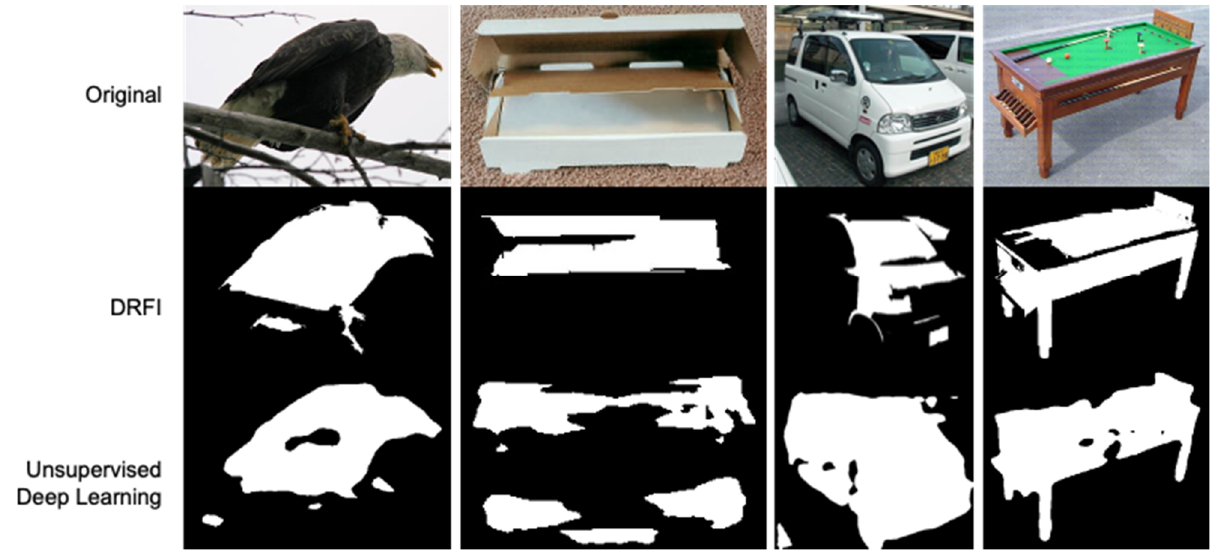
Figure 2. Example of heuristic binary masks used for mask contrastive learning framework. First row: random images from the ImageNet [24] training set. Second row: mask generated based on DRFI algorithm with a predefined sigma σ value of 0.8 and component size values of 1000. The third row is the mask obtained from the self-supervised pre-trained feature extractor ResNet-50 backbone directly followed by a 1 × 1 convolutional classification foreground and background prediction.